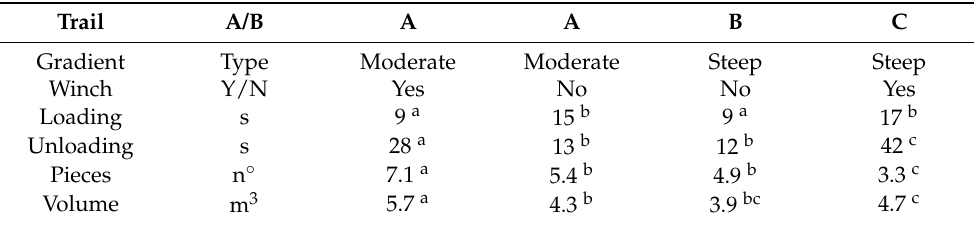
Table 5. Loading time, unloading time and load size: mean values recorded under the different treatments.